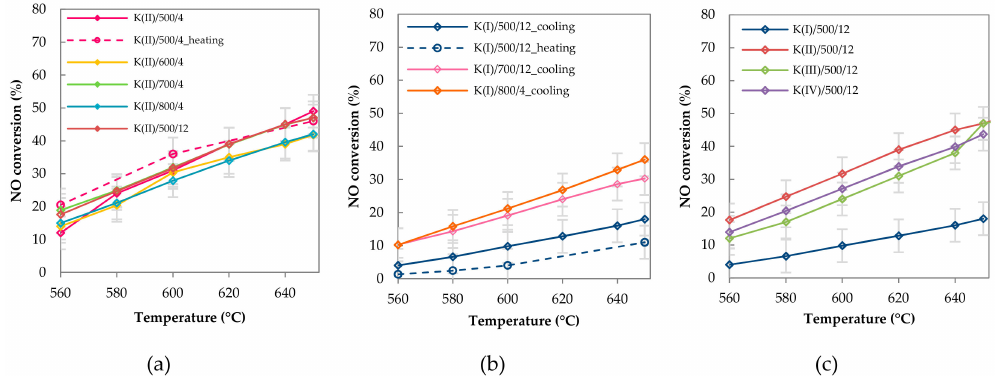
Figure 11. Temperature dependence of the NO conversion ( a ) the effect of calcination temperature and time, K(II) / y / z catalysts, ( b ) effect of different procedures of catalytic measurement, K(I) / y / z catalysts and the ( c ) effect of K content, K( x ) / 500 / 12 catalysts. Conditions: 1000 ppm NO balanced by N 2 , GHSV = 6 l g − 1 h − 1 .